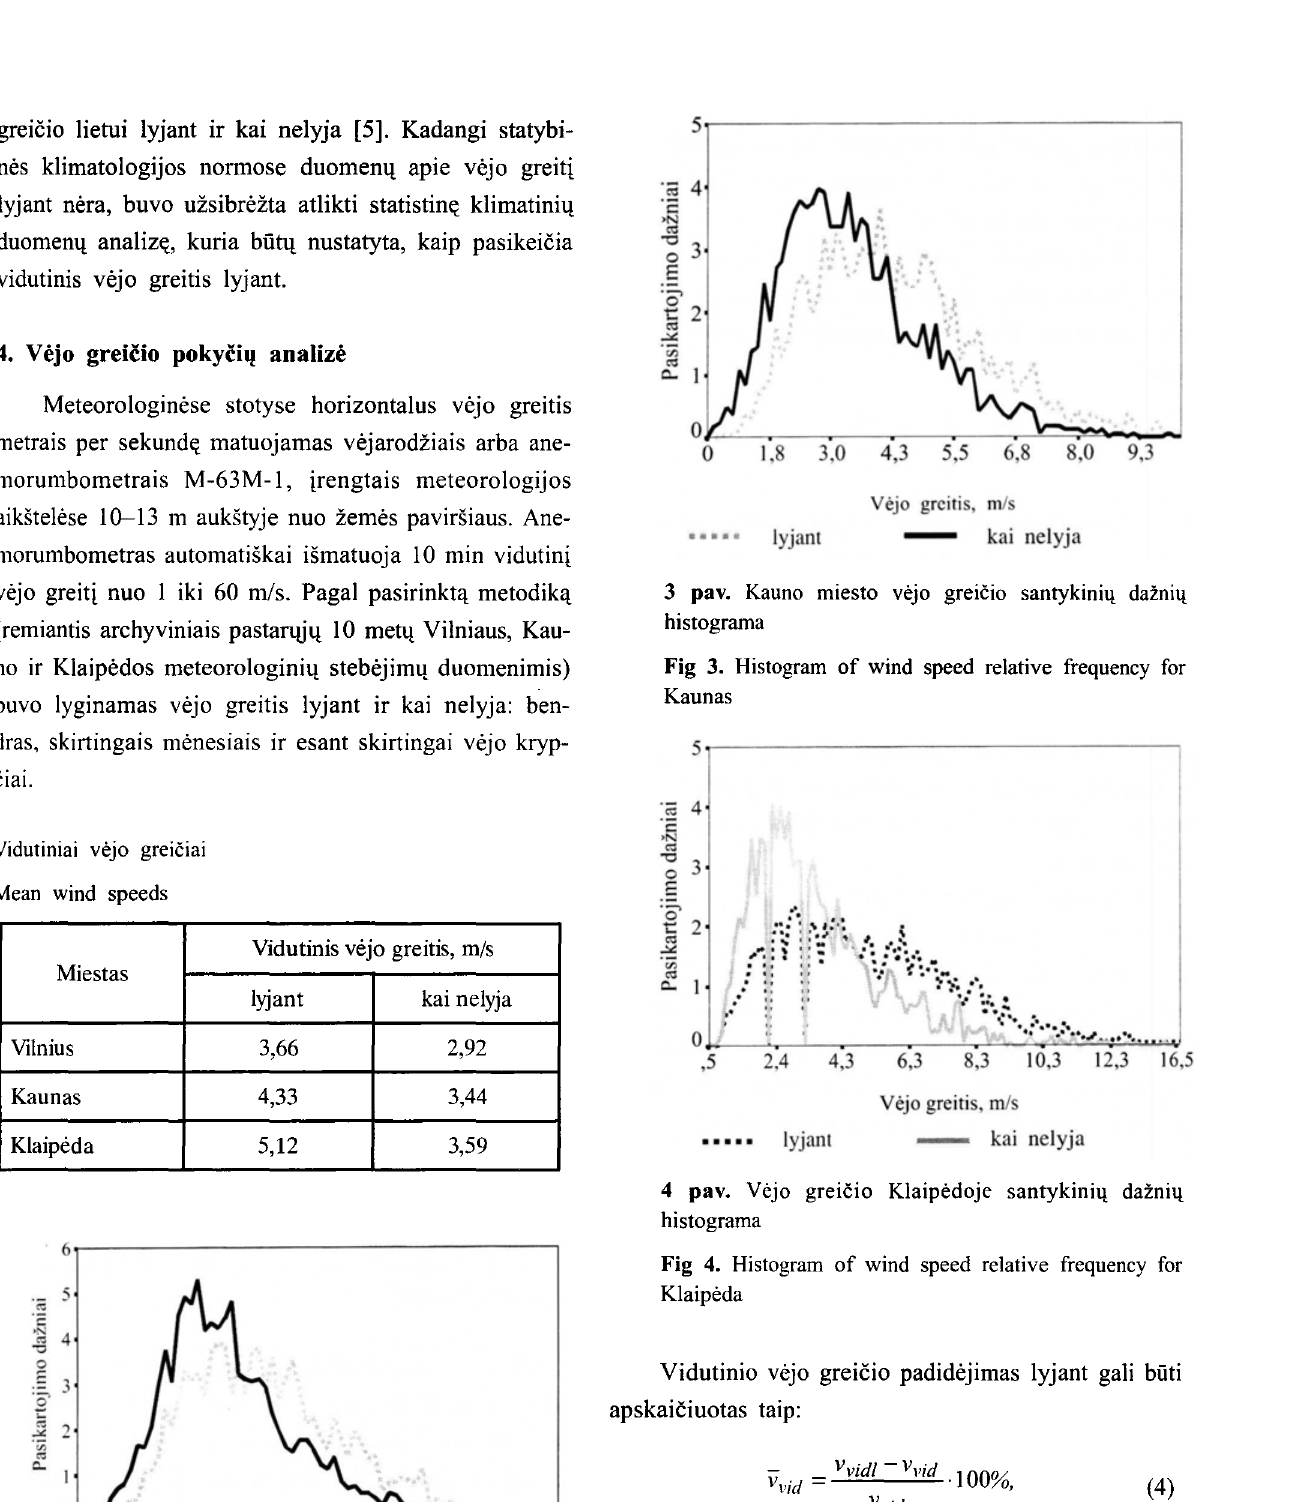
Fig 4. Histogram of wind speed relative frequency for